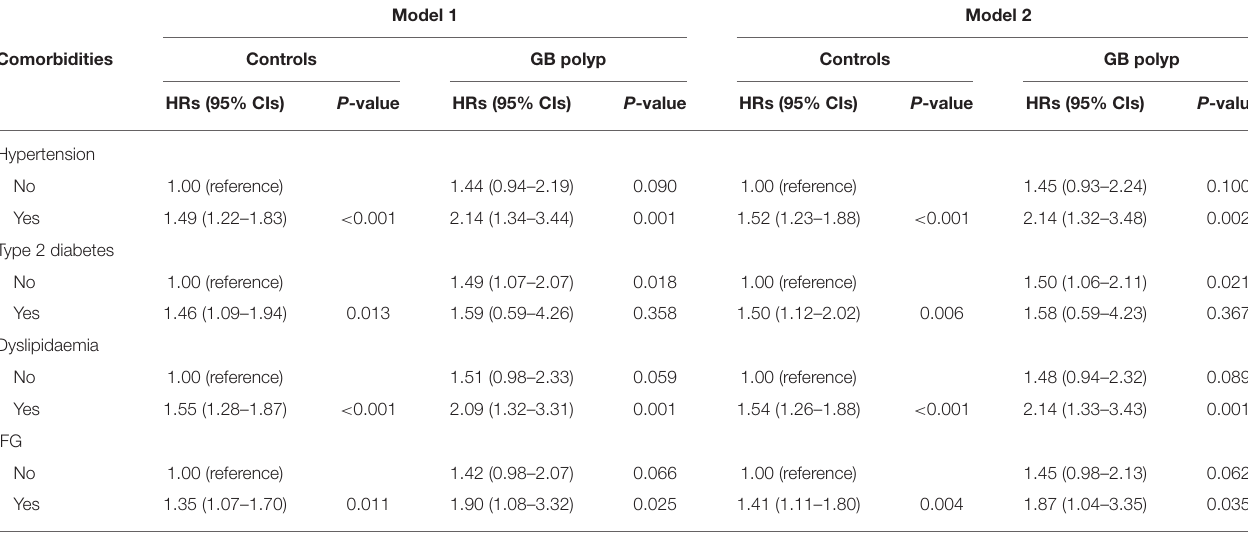
TABLE 4 | Hazard ratios and 95% confidence intervals for ischaemic heart disease according to gallbladder polyp in the context of metabolic diseases. Model